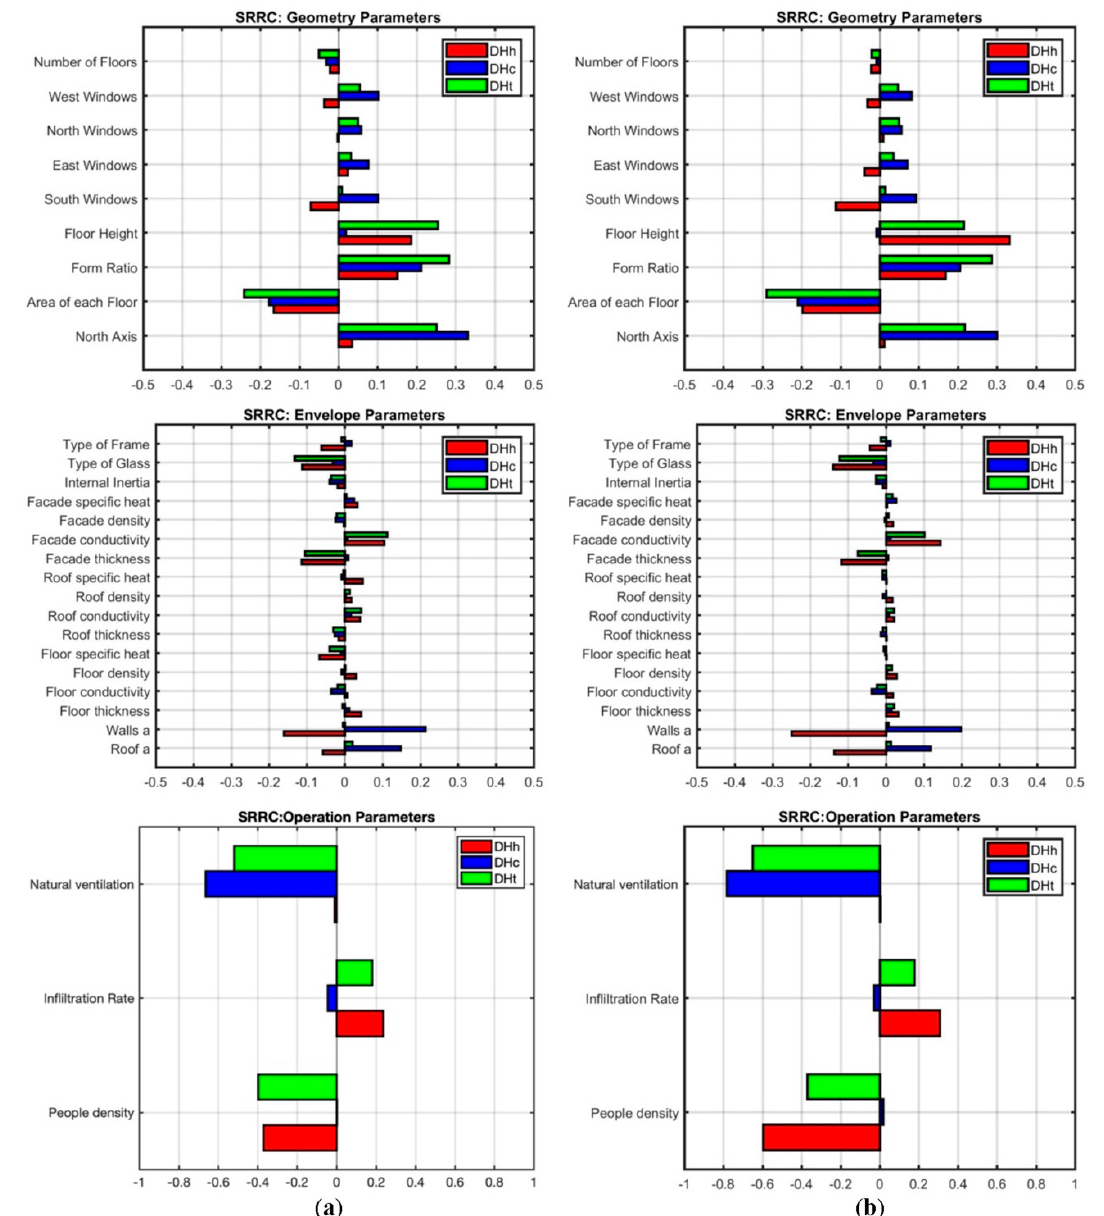
Figure 8. Standard rank regression coefficients (SRRCs) in relation to discomfort hours (DH h , DH c and DH) for geometry, envelope and operation parameters: ( a ) under typical climatic conditions; ( b ) for the 2050 climate scenario.